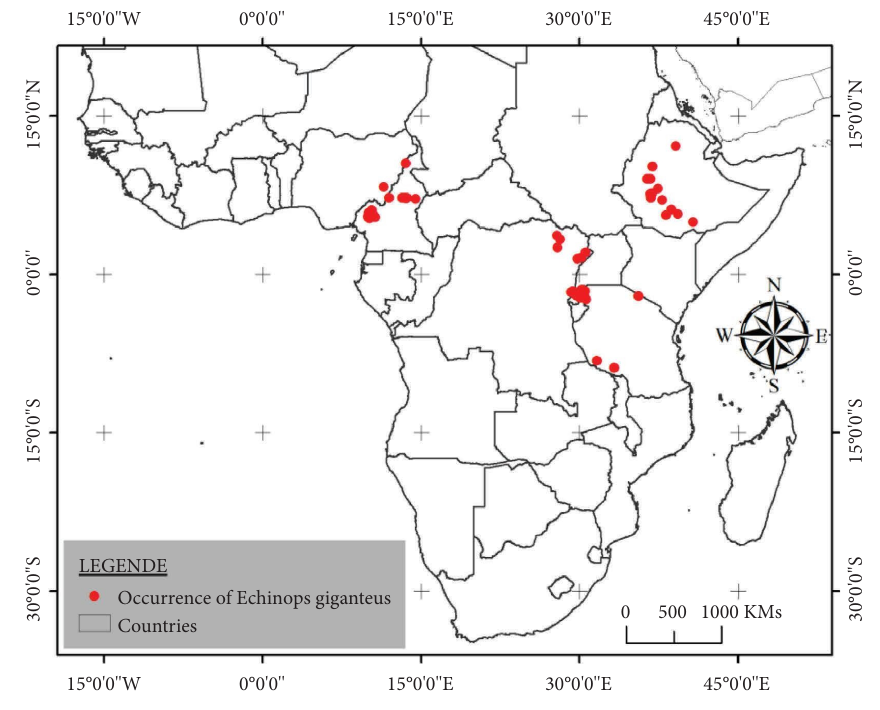
Figure 2: Distribution of Echinops giganteus in Africa.